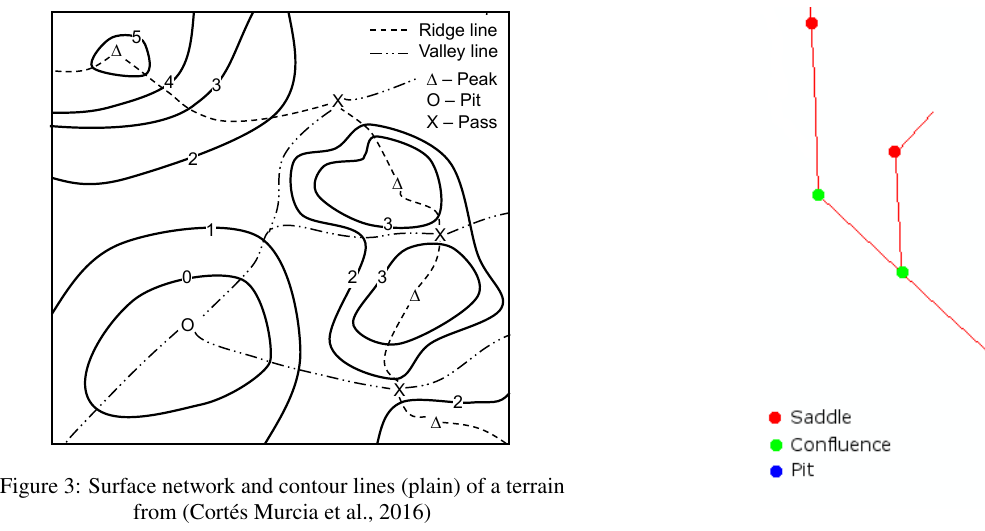
Figure 4: Segmentation of 3 thalwegs connected to a same pit into